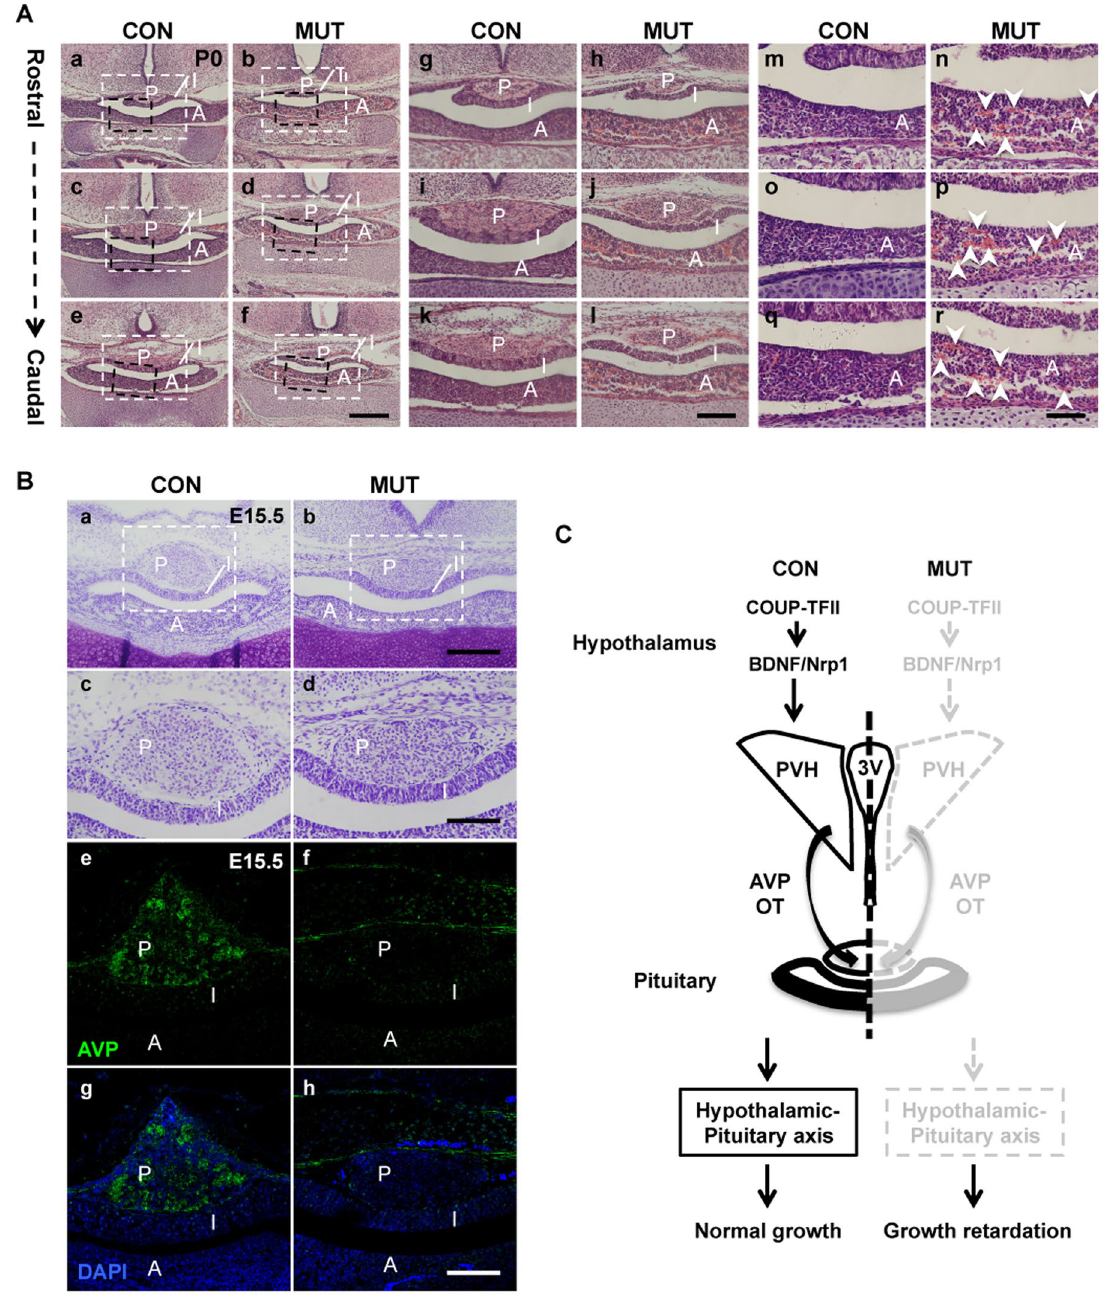
Figure 7. COUP - TFII ensures the appropriate morphogenesis and function of the hypothalamic-pituitary axis, especially the PVH nucleus, to prevent growth retardation. ( A ), The development of both posterior and anterior pituitary is abnormal in the newborn mutant. ( A g–i) White inserts in ( A a–f). ( A m–r) Black inserts in ( A a–f). H&E staining showed that compared with the control ( A a,c,e,g,i,k), the posterior pituitary is shrunken along the rostro-caudal axis in the mutant at P0 ( A b,d,f,h,j,l). There are a few isolated blood cells in the anterior pituitary of the control ( A m,o,q); however, many blood cell clusters, indicated by white arrow-heads, are observed in the mutant anterior pituitary ( A n,p,r). ( B ) The projection of AVP neuron to the posterior pituitary is abnormal in the mutant embryo at E15.5. Nissl staining images of the pituitary in the control ( B a,c) and the mutant at E15.5 ( B b,d). ( B c,d) Inserts in ( B a,b). The expression of AVP is readily detected in the control posterior pituitary at E15.5 ( B e,g), but not in the mutant posterior pituitary ( B f,h). ( C ) A working model: during early development, COUP - TFII may activate or maintain the expression of Bdnf and Nrp1 genes to ensure the appropriate morphogenesis and function of the hypothalamic-pituitary axis, especially the PVH nucleus, and to prevent the growth failure. 3 V, third ventricle; A, anterior pituitary lobe; I, intermediate pituitary lobe; P, posterior pituitary lobe; PVH, paraventricular nucleus of hypothalamus. Scale bar, ( A a–f) 400 μ m; ( A g–l) 200 μ m; ( A m–r) 100 μ m; ( B a,b) 200 μ m; ( B c–h) 100 μ